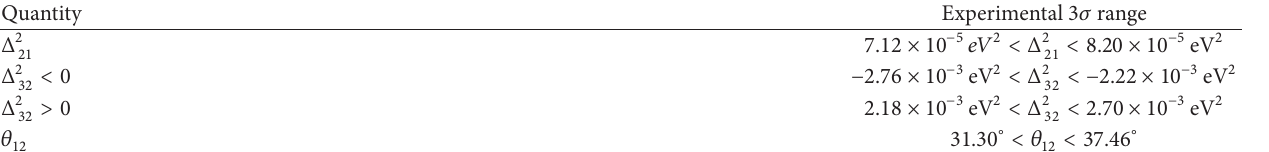
Table 4: Input experimental values